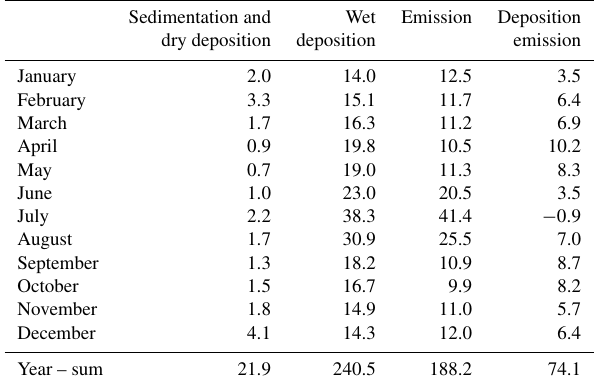
Table 2. Arctic BC budget averaged for the years 2005–2015 (in ktmonth − 1 ) for